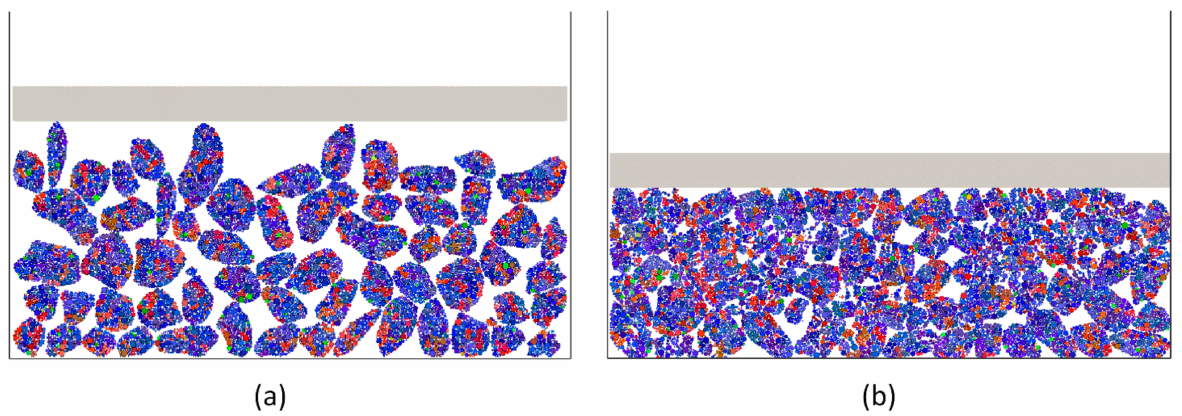
Figure 12. Setup of the whole particle bed test in YADE: Configuration at the beginning of the test ( a ) and during the particle bed comminution ( b ).